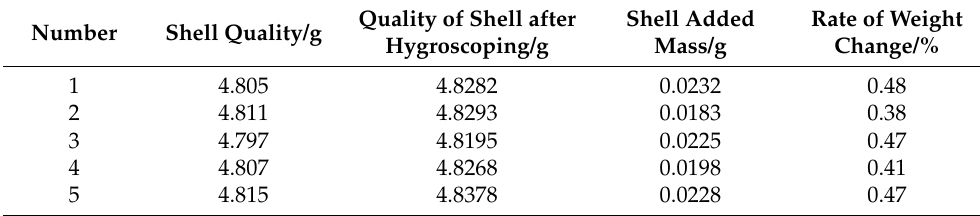
Table 1. Results of hygroscopicity of